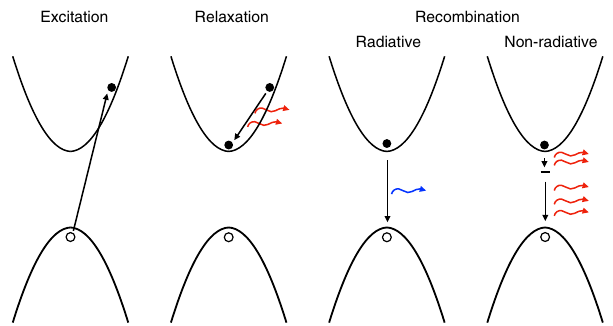
FIG. 12. Simplified band-structure representation of typical e − h þ excitation, relaxation, and recombination processes. From left to right, in the first step, a scattering event excites an electron (black circle) from the valence band into the conduction band, leaving a hole (empty circle) behind. In the second step, the electron releases its excess energy in the form of phonons (red arrows) and moves to the bottom of the conduction band. Recombination of the electron and hole may then happen directly across the band gap via the emission of a near-band-gap photon (blue arrow). Another possibility, shown in the rightmost panel of the figure, is that there is an available energy level between the valence and conduction bands, referred to as a “ trap, ” due to impurities in the material. In this case, the electron is first captured by the trap and may subsequently recombine with the hole, with the released energy usually going into multiple phonons. While we show a direct band gap, our schematic description is valid for both direct and indirect gap